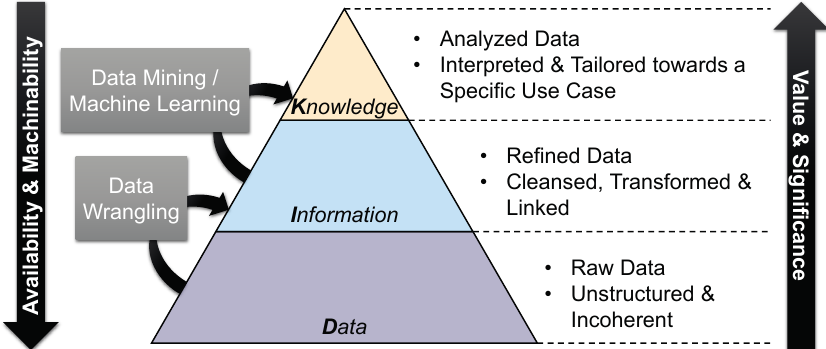
Figure 1. Data pyramid illustrating the relationships between data, information, and